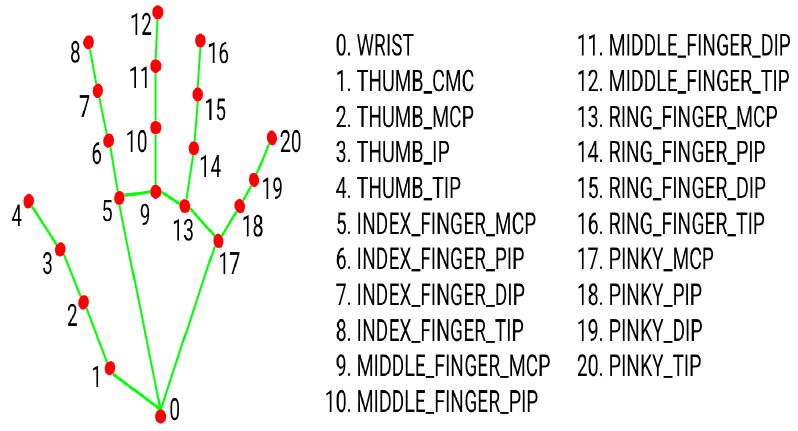
Figure 2. The order and labels for keypoints that exist in the hands of MediaPipe